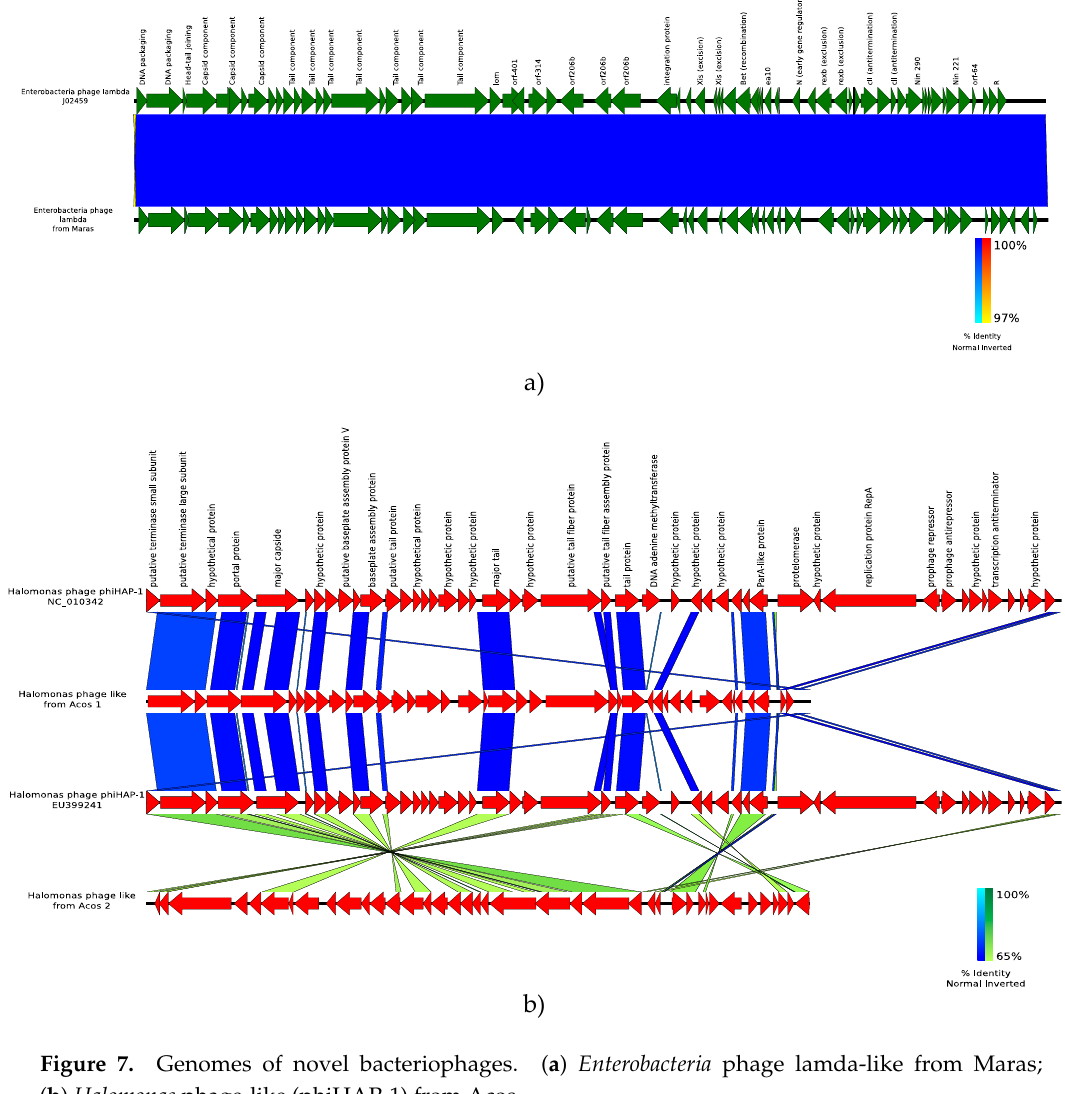
Figure 7. Genomes of novel bacteriophages. ( a ) Enterobacteria phage lamda-like from Maras; ( b ) Halomonas phage-like (phiHAP-1) from Acos.